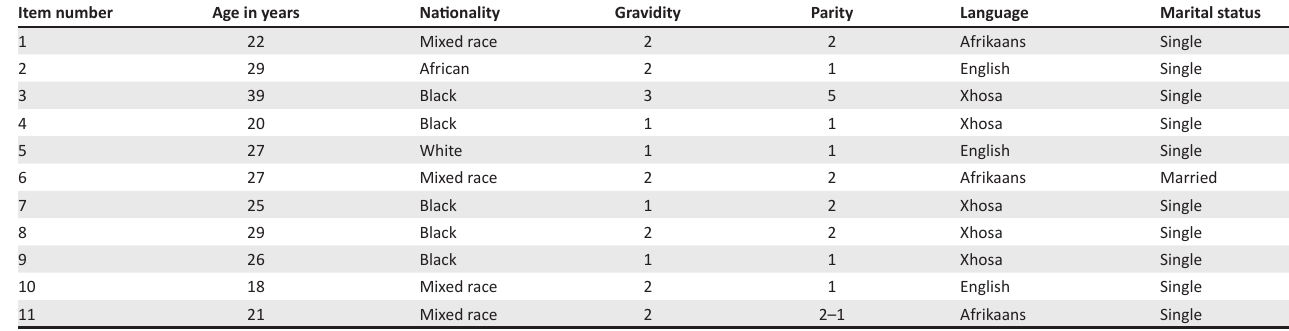
TABLE 1: Demographic profile of participants. Item